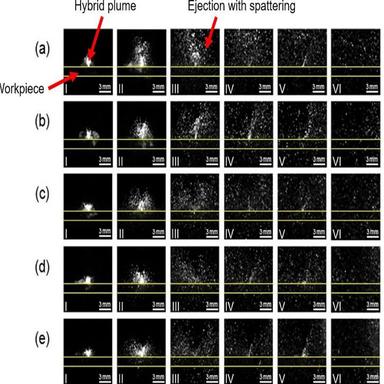
High-speed photography images showing the transient evolution of the blind-hole drilling stage using the first laser pulse with different argon pressures of (a) 0.05 MPa, (b) 0.1 MPa, (c) 0.15 MPa, (d) 0.2 MPa and (e) 0.25 MPa.